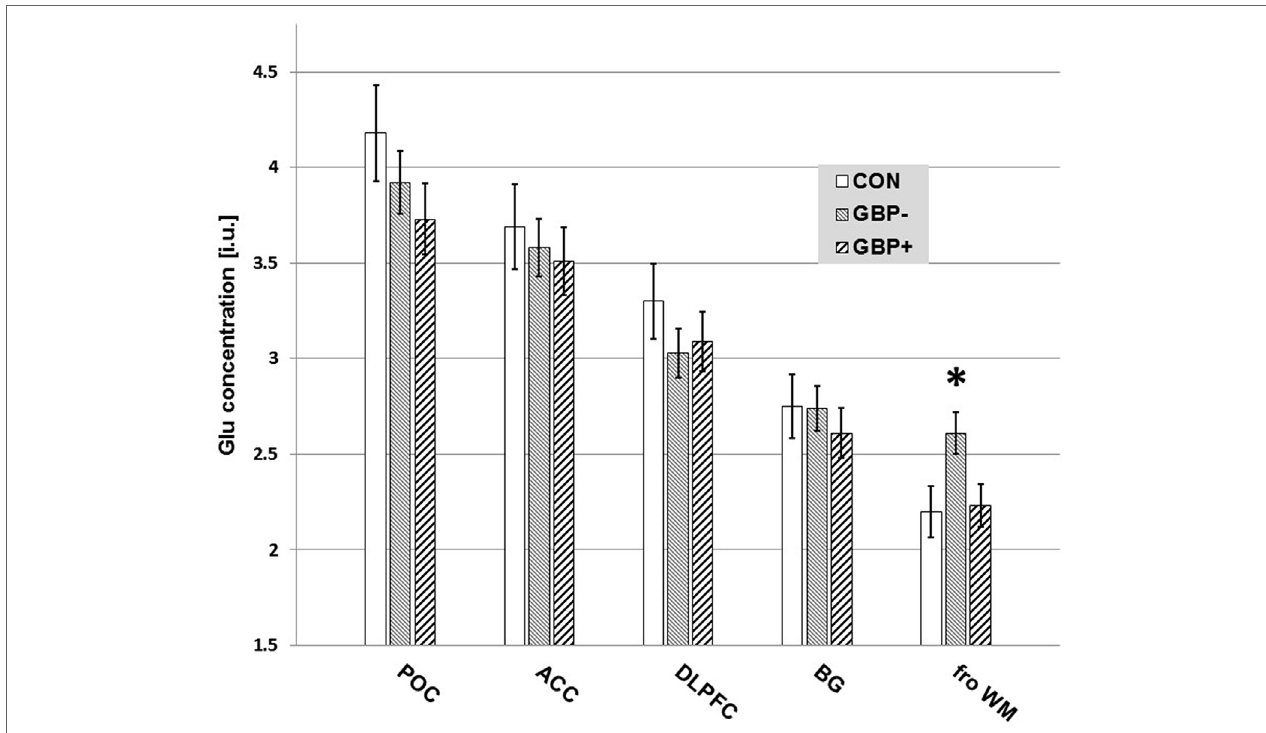
FigUre 2 | Measured glutamate (Glu) concentrations [institutional units (i.u.)] by volume-of-interest and group. Mean ± SE. Only the differences in frontal white matter (fro WM) Glu of GBP − to GBP + ( p = 0.017) and controls (CON) ( p = 0.026) reached statistical